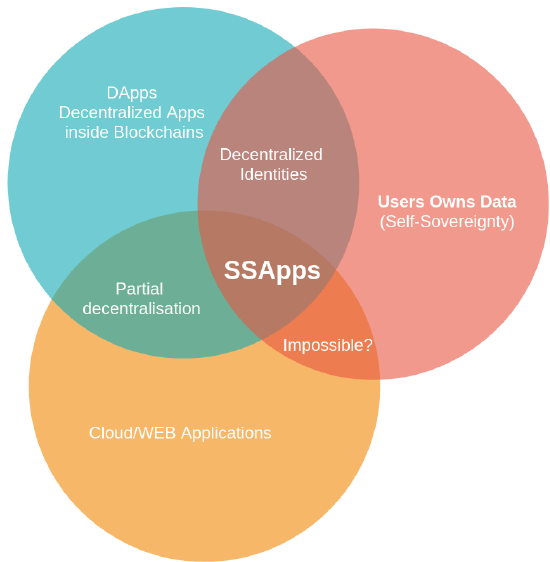
Figure 2. Positioning of SSApp concept from the open